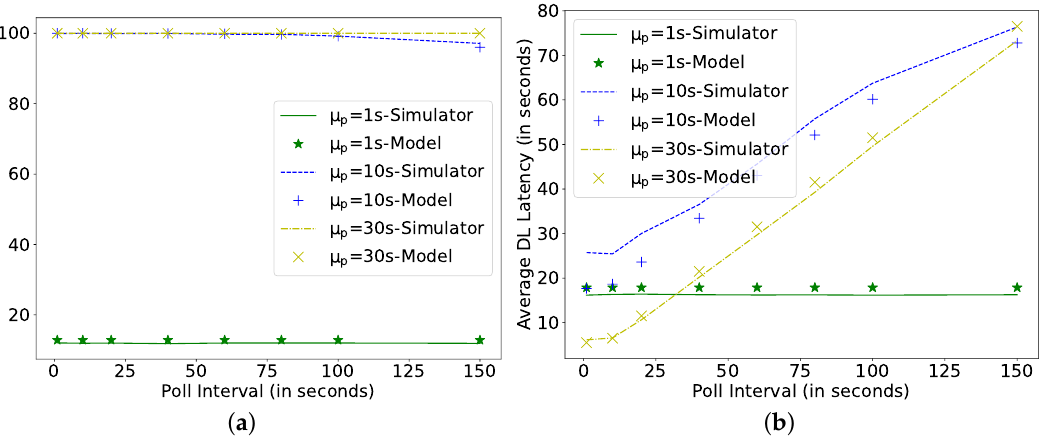
Figure 11. Comparing simulator and model for different Poll Intervals at C = 0.1 mF, P h = 0.1 mW, N = 16, T AT = 0 ms. ( a ) Average packet delivery ratio; ( b ) DL